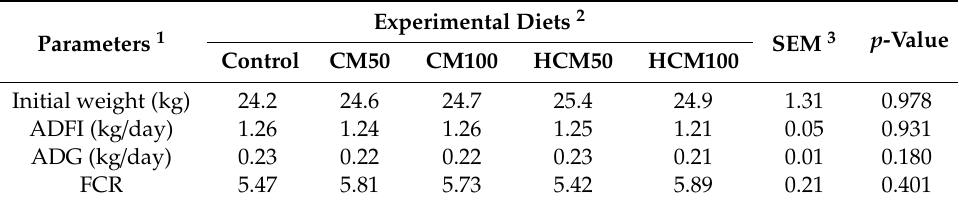
Table 3. Dietary e ff ect of partially or completely replacing soybean meal with untreated or heat-treated canola meal on feed intake and growth performance of Meatmaster